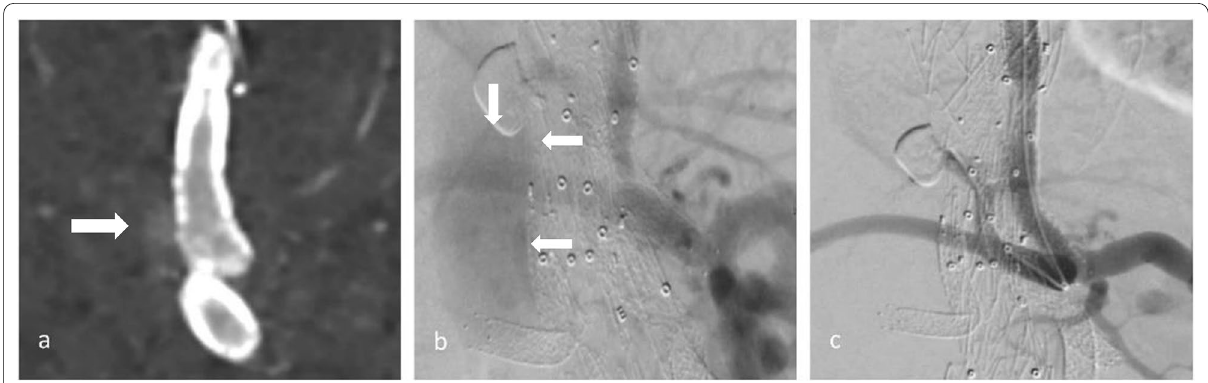
Fig. 2 Membrane disruption of BSG in celiac trunk with visible endoleak in CTA ( a ) and angiography before ( b ) and after religning ( c